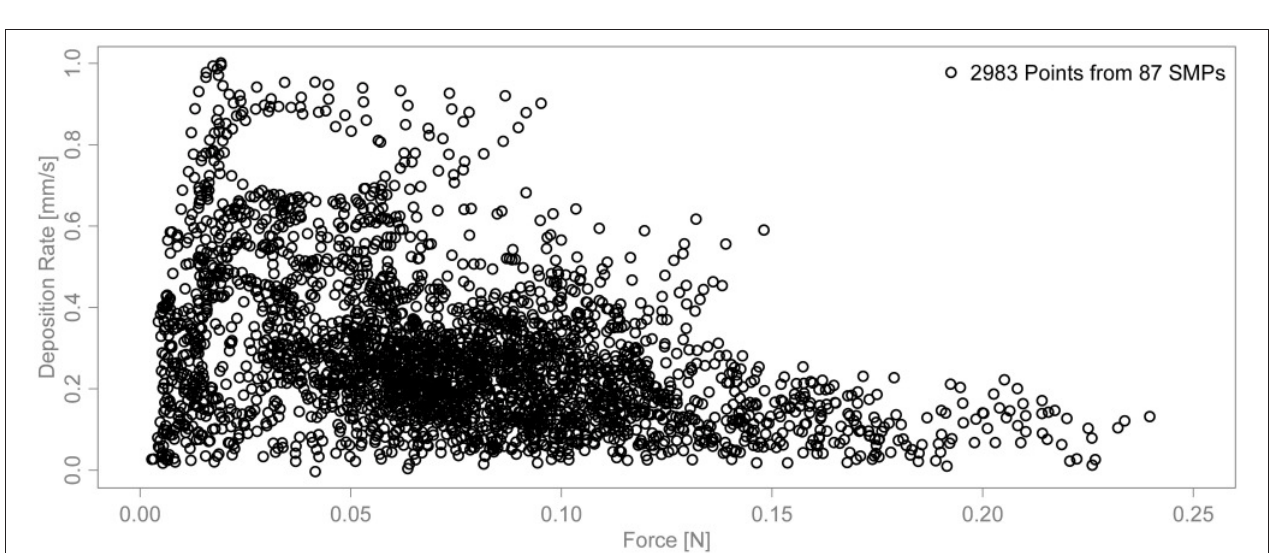
edges of zastrugi are formed. The formation of zastrugi has been described in detail by e.g., Doumani (1967), Filhol and Sturm (2015), and Goodwin (1990). The potential hardening effect of erosion is not discussed,